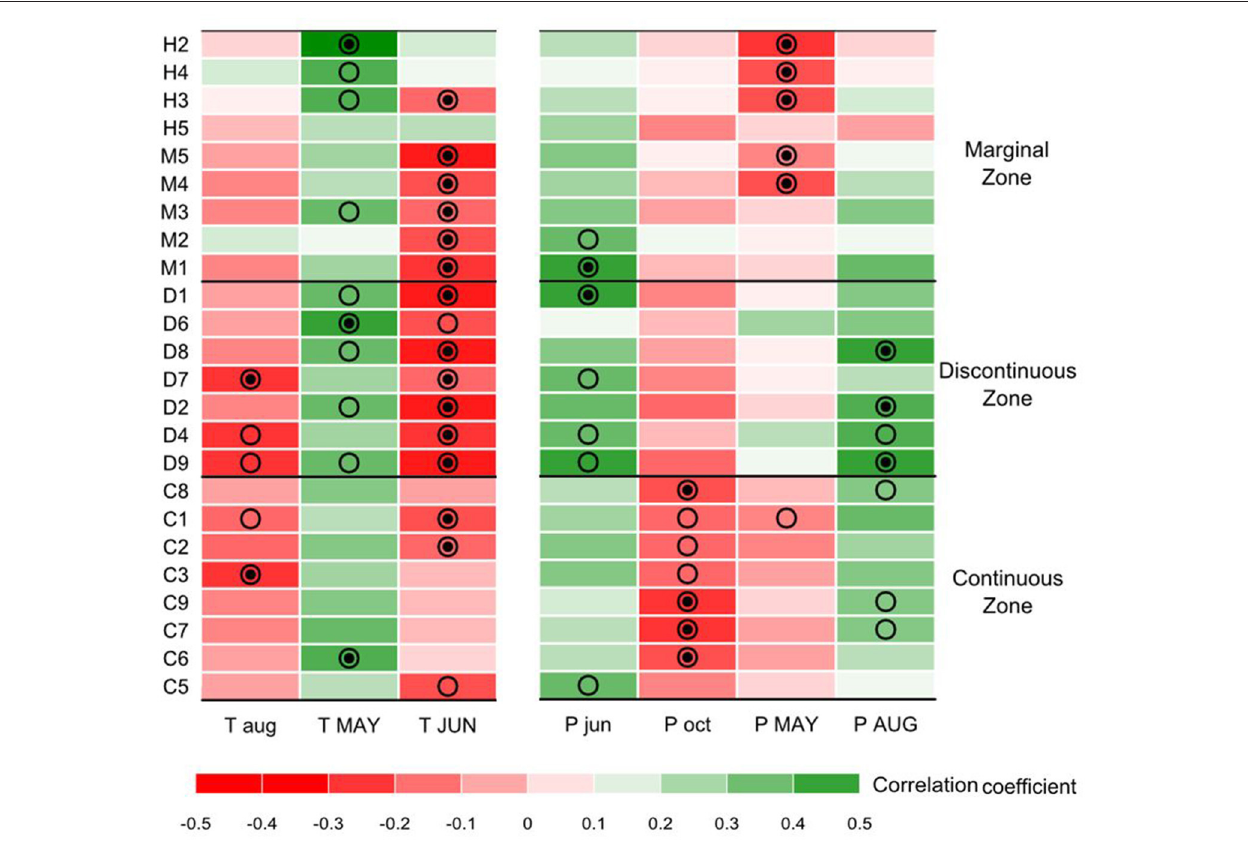
FIGURE 2 | Growth-climate correlation matrix for the seven main monthly climatic drivers of radial growth interannual variations (columns) and the 24 sites (rows). Months in capital letters code for climate variables of the current year and, small letters for the year preceding ring formation. Colors represent the correlation coefficients scores computed between Thuja occidentalis residual tree-ring index chronologies and monthly mean temperature and monthly precipitation. Significant correlations are represented by dots ( • ) for the bootstrapped response function and by circles ( (cid:13) ) for the correlation function. Sites are presented in order of increasing number of mean annual growing degree-days over the 1953–2010 period, the coldest sites being at the